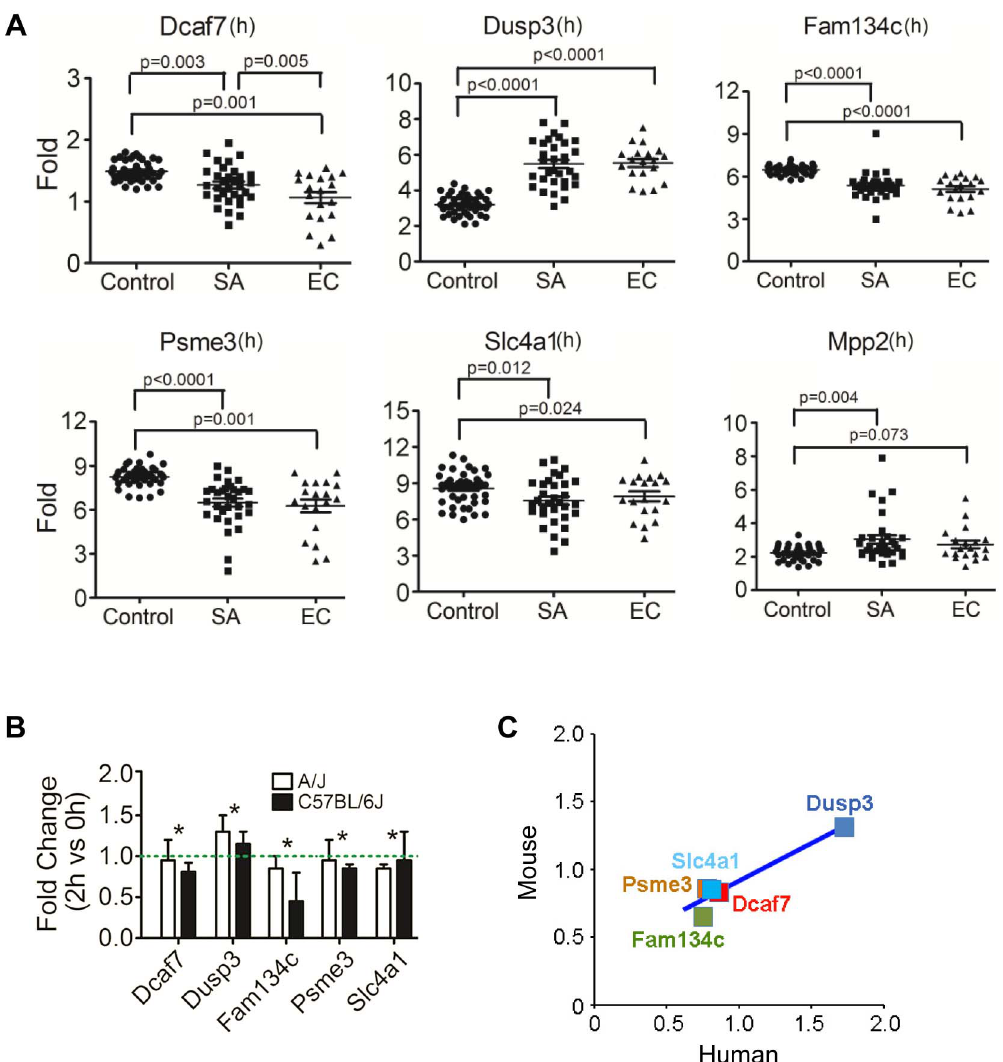
Figure 3. Human orthologues of six candidate genes were significantly differentially expressed between patients with S.aureus blood stream infection (BSI) and healthy subjects, and five of these genes ( Dcaf7 , Dusp3 , Fam134c , Psme3 , and Slc4a1 ) demonstrated consistent uninfected vs infected expression patterns between mouse and human. ( A ) Human orthologues of six candidate genes ( Dcaf7 , Dusp3 , Fam134c , Psme3 , Slc4a1 , and Mpp2 ) were significantly differentially expressed between patients with S. aureus BSI and healthy subjects by microarray. Human blood RNA from patients with S. aureus BSI (n=32) and healthy subjects with no infection (n=43) were extracted and analyzed and applied to microarray. The expression of Dusp3 (1.73 fold; p , 0.0001) and Mpp2 (1.21fold; p=0.004) were significantly higher in S. aureus BSI patients as compared with healthy controls, and the expression of Dcaf7 (0.85fold; p=0.003), Fam134c (0.75fold; p , 0.0001), Psme3 (0.78fold; p , 0.0001), and Slc4a1 ( 0.81fold ; p=0.012) were significantly lower in S. aureus BSI patients. Six genes showed similar significant expression changes in E. coli BSI (n=19) patients as compared with healthy subjects (n=43) ( B ) Quantitative-PCR validation of the six genes identified five candidate genes ( Dcaf7 , Dusp3 , Fam134c , Psme3 and Slc4a ) with consistent uninfected vs infected expression patterns between mouse and human. Dcaf7 (0.83fold), Dusp3 (1.31fold), Fam134c (0.65fold), Psme3 (0.86fold), and Slc4a1 (0.85fold). Both eight-week-old male A/J and C57BL/6J mice were i.p. injected with S. aureus Sanger 476 at 10 7 CFU/g (n=6 for each strain), at two hours post infection all mice were sacrificed by CO 2 inhalation and whole blood were obtained through cardiac puncture. Blood RNA were extracted by QIAGEN RNeasy Protect Animal Blood Kit, and then subjected to reverse- transcription PCR and SYBR-green quantitative-PCR. The expression of all target genes were normalized to 18s rRNA. ( C ) Scatter plot of fold changes of the five candidate genes showed a consistent pattern between mouse and human. For human data analysis, the expression level of the non- infection healthy controls was set to 1, and the expression level of S. aureus BSI patients was normalized to the non-infection level to get the fold change. For mouse data, the fold changes were average between A/J and C57BL/6J mice.